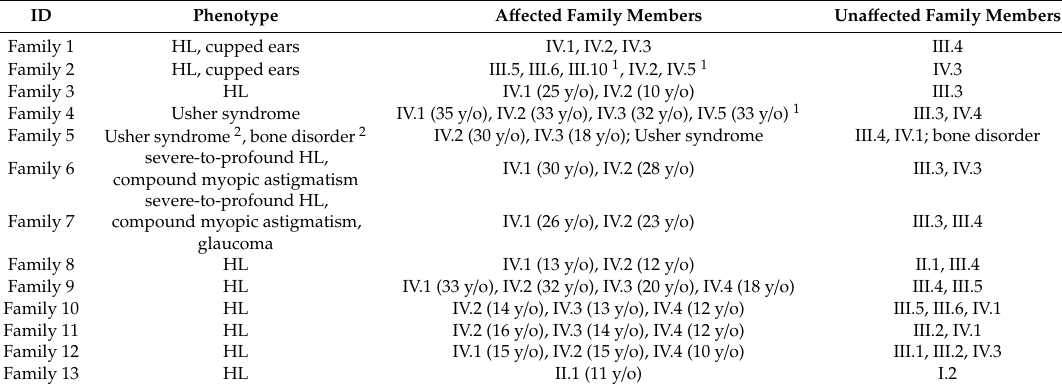
Table 2. Clinical information for Pakistani